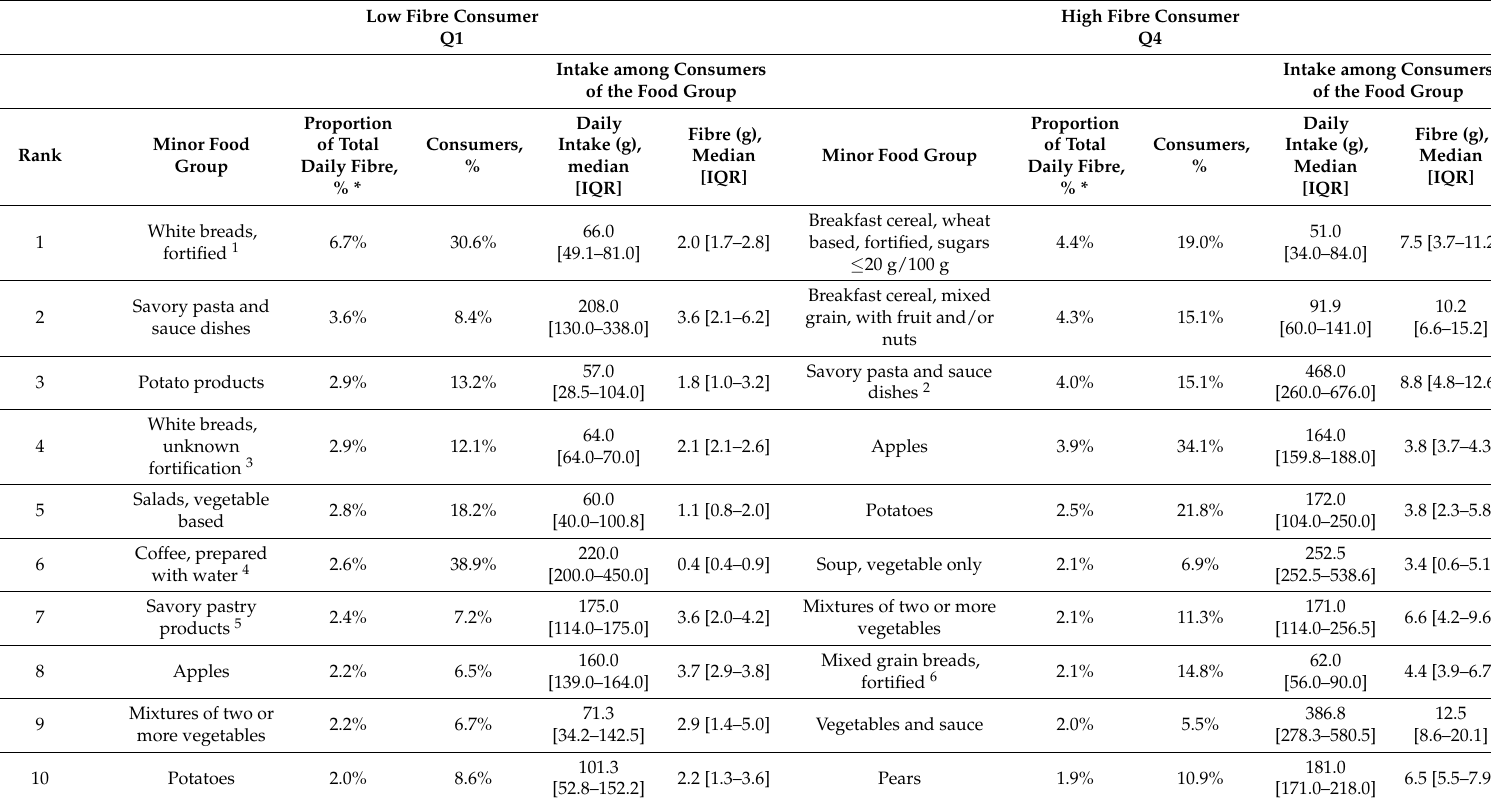
Table 6. Leading minor food groups by contribution to dietary fibre intake in adults aged 19 years and